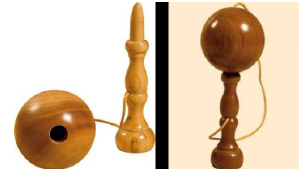
Figure 22. The Cup-and-Ball